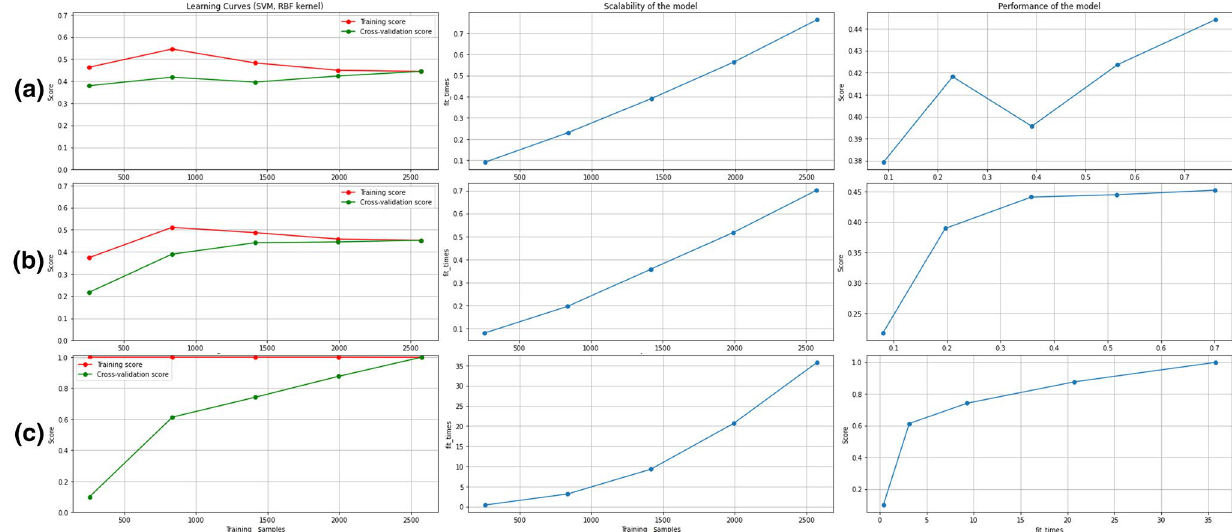
Fig. 2 Learning curve and scalability of the multiclass classification approaches ( a ) Bernoulli naïve Bayes, ( b ) multinomial naïve Bayes, and ( c ) support vector classification, using original splits of the MDRM